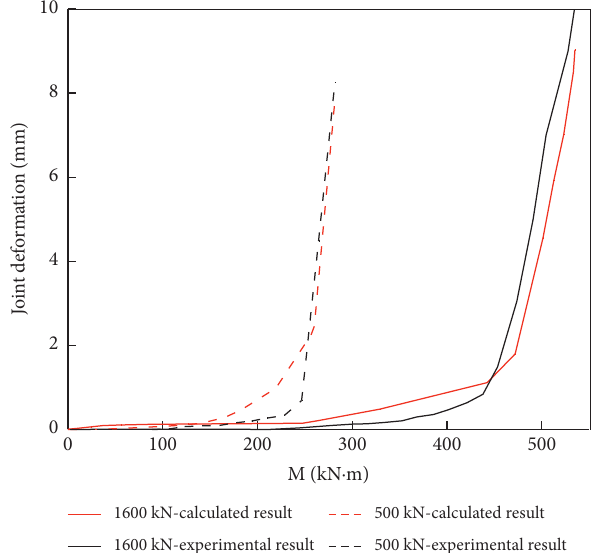
Figure 19: Comparison of joint deformation for calculated results and experimental results.